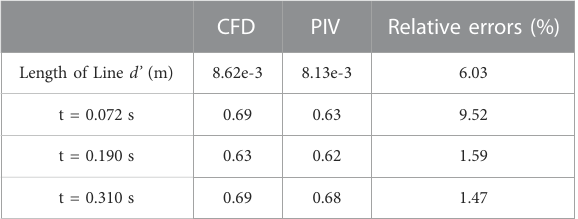
TABLE 2 Comparisons in averaged V* between PIV measurements and CFD simulations under selected time instants. CFD PIV Relative errors (%) Length of Line d ’